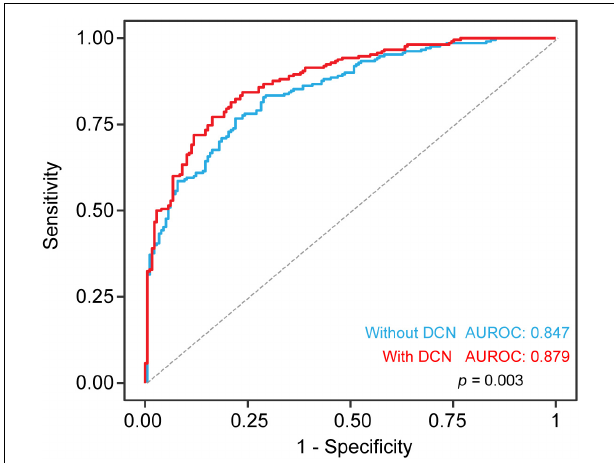
FIGURE 3 | Diagnostic accuracy for ACS with serum DCN. The receiver operating characteristic curve (ROC) including clinical risk factor with or without serum DCN for the diagnostic value of ACS in all patients. Risk factors includes age, sex, smoking, hypertension, diabetes, systolic BP, WBC, HbA1c, total cholesterol, HDL, LDL, creatinine. Sensitivity (y axis) and 1-specificity was plotted as